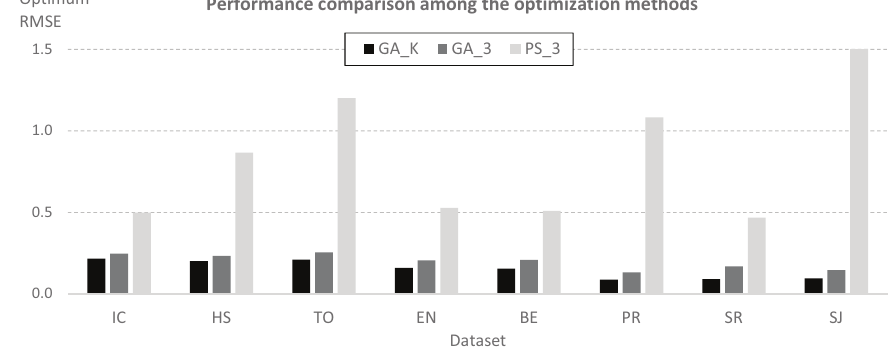
Figure 10. Performance comparison among the three optimization